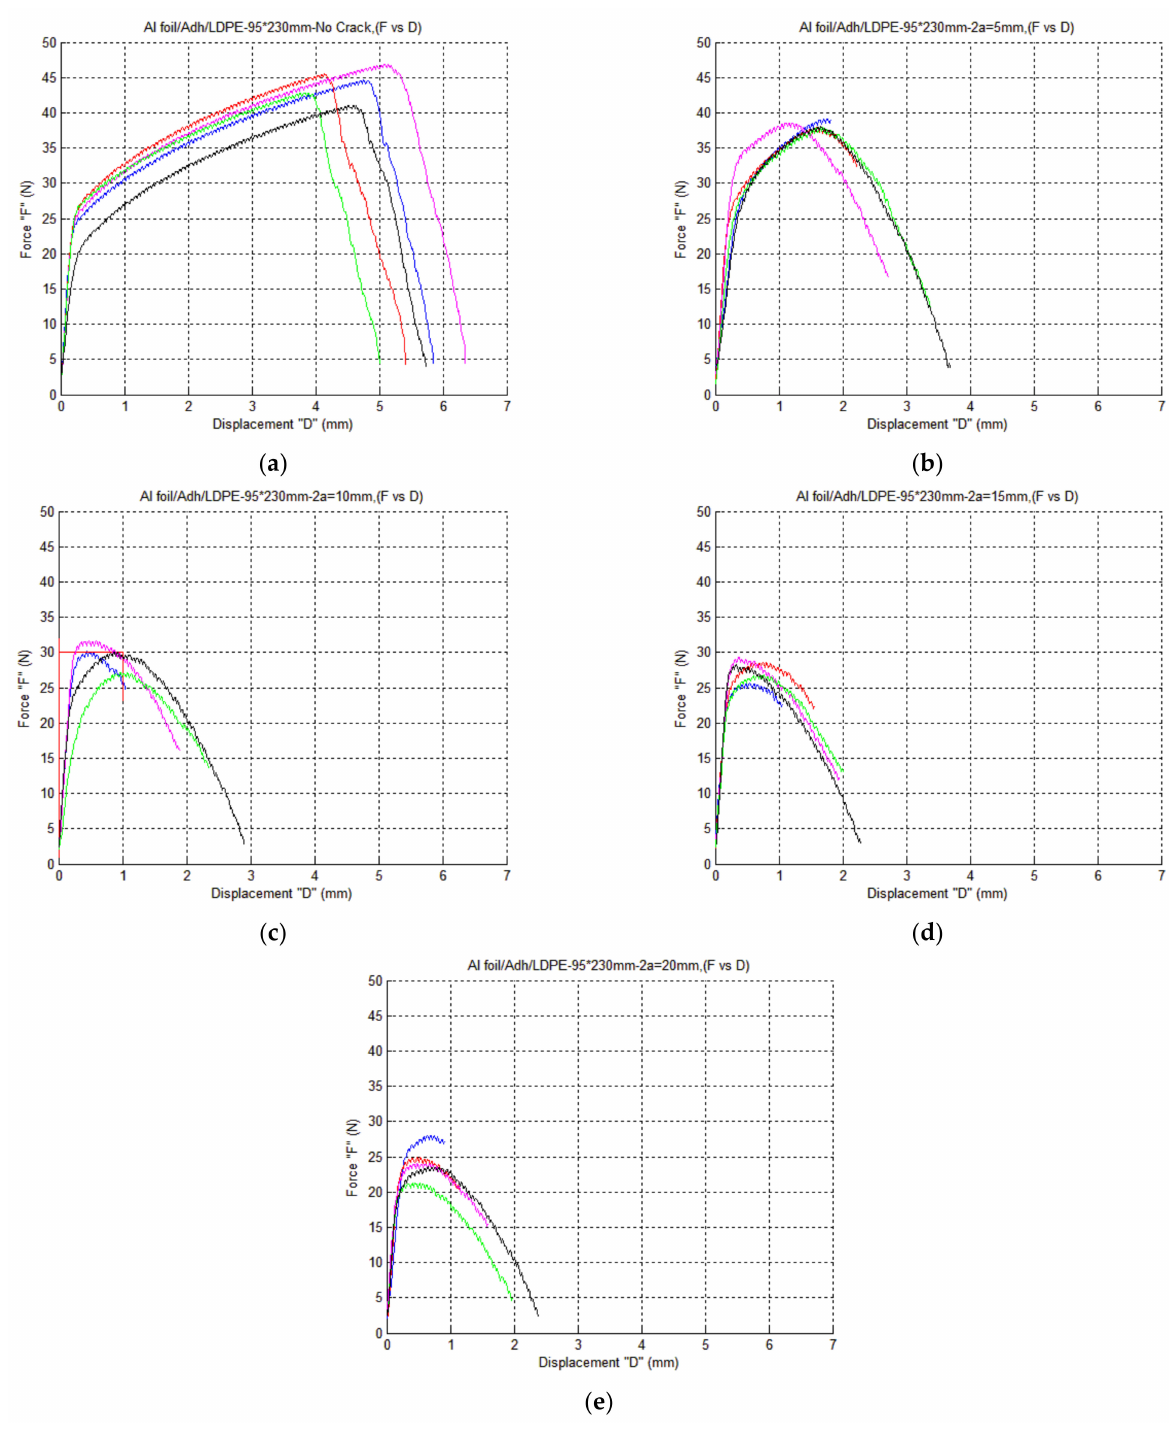
Figure A3. Experimental results for aluminum foil/Adh/LDPE. ( a ) F vs. D for 0 mm crack, ( b ) F vs. D for 5 mm crack, ( c ) F vs. D for 10 mm crack, ( d ) F vs. D for 15 mm crack, ( e ) F vs. D for 20 mm